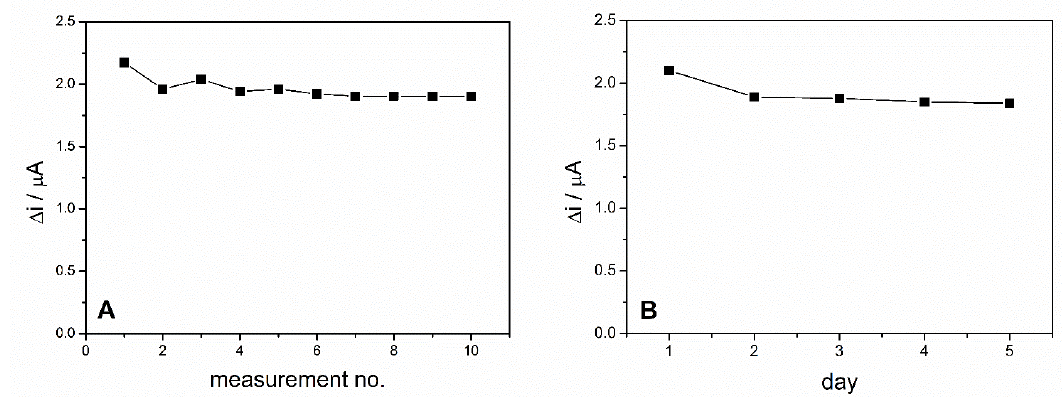
Figure 7. ( A ) Operational stability of the ADH-sol-gel/PAH/SPE biosensor. ( B ) Long term stability of the ADH-sol- gel/PAH/SPE biosensor E = +500 mV, PBS 0.1 M pH = 8.8, [NAD + ] = 10 mM, ethanol 4 mM).